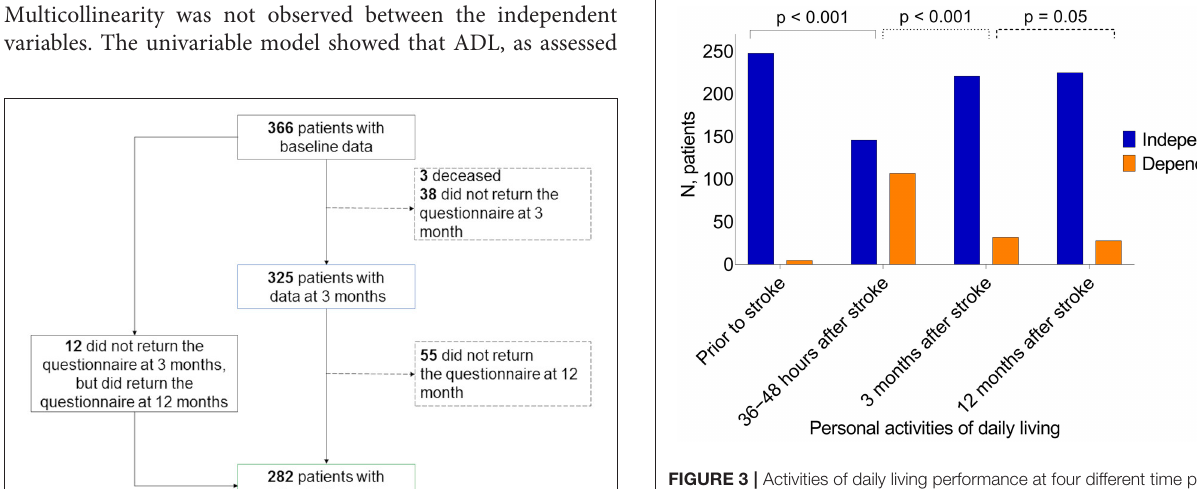
FIGURE 3 | Activities of daily living performance at four different time points. Statistics, McNemar’s test, P -values indicate statistical difference between following time points, ADL dependency before the stroke and 36–48h after stroke, 36–48h and 3 months after stroke, 3 and 12 months after the